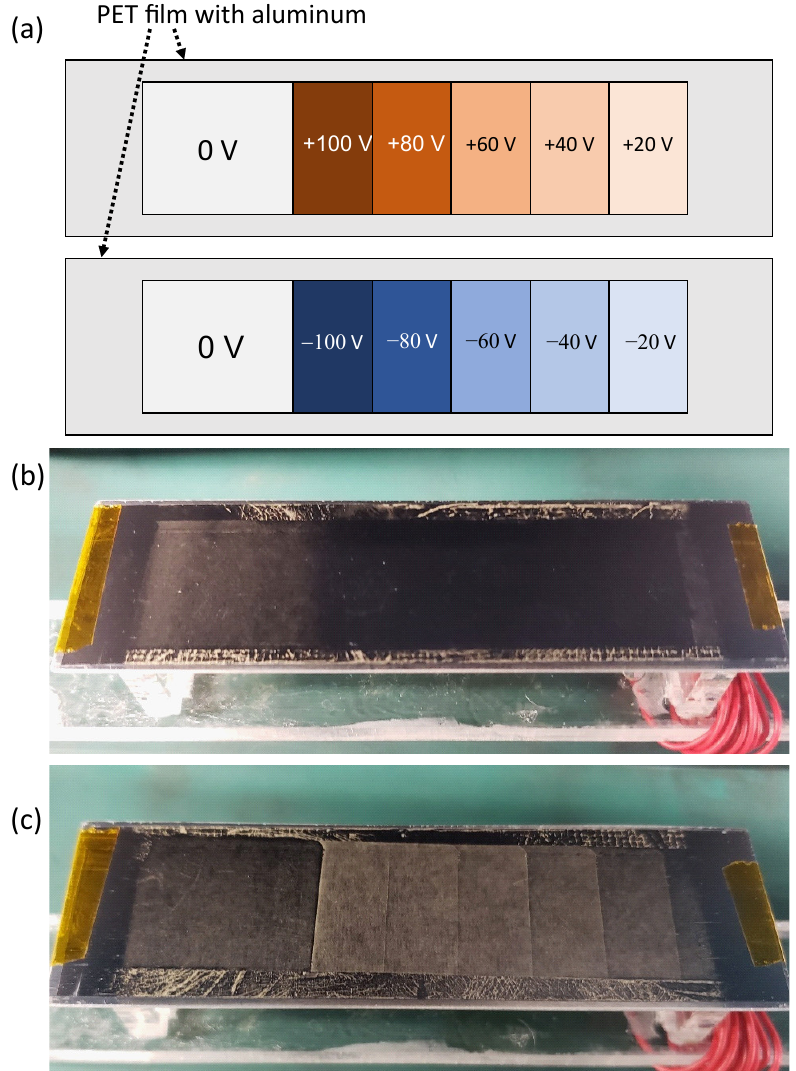
Figure 4. ( a ) Schematic illustration of the gradation electrostatic potential applied on the PET film. ( b ) Photograph of the developed Ag–Ni toner pattern on the positive gradation-charged PET surface. ( c ) Photograph of the developed Ag–Ni toner pattern on the negative gradation-charged PET